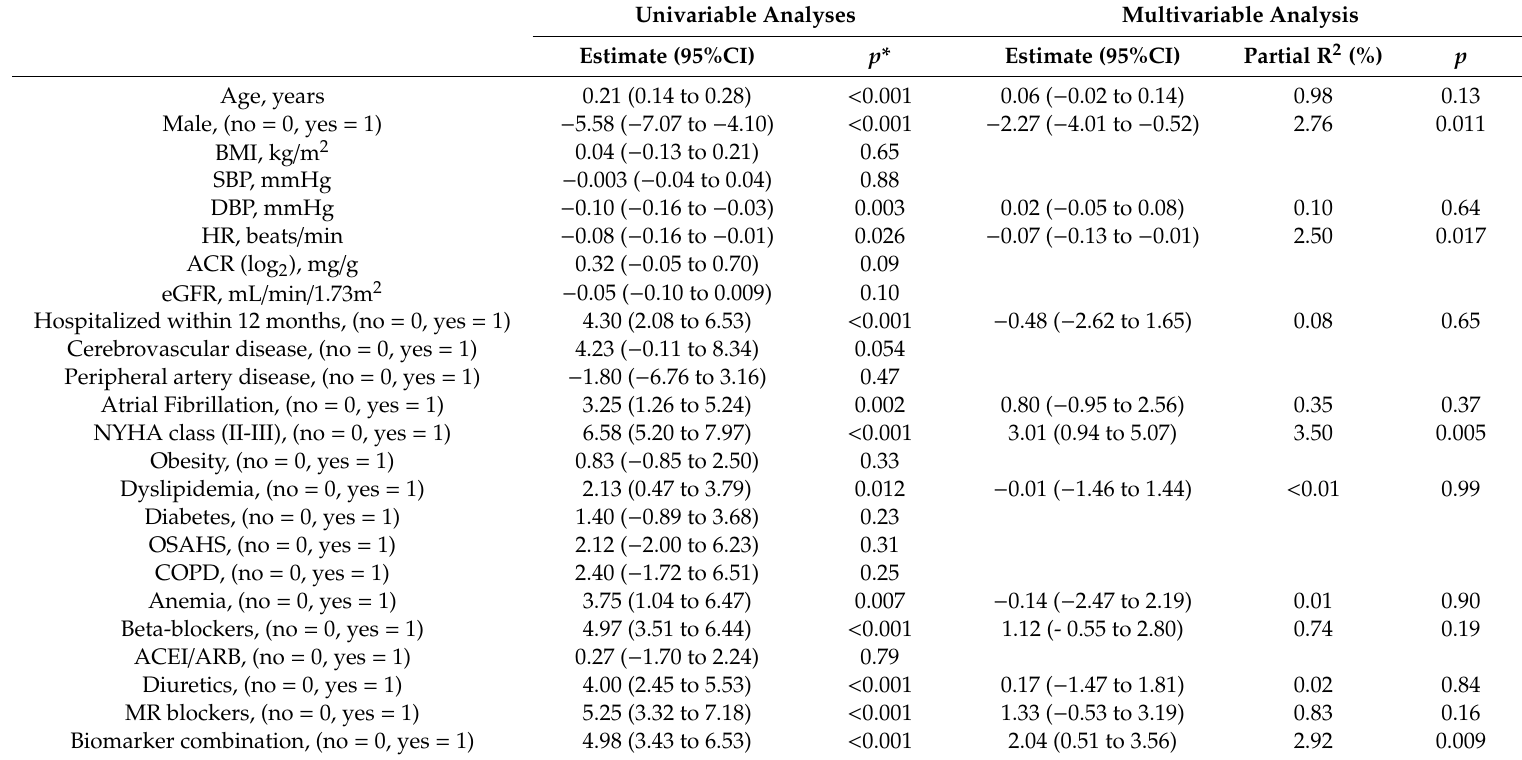
Abbreviations as in Table 1. * Variables with p < 0.05 were selected for the multivariable